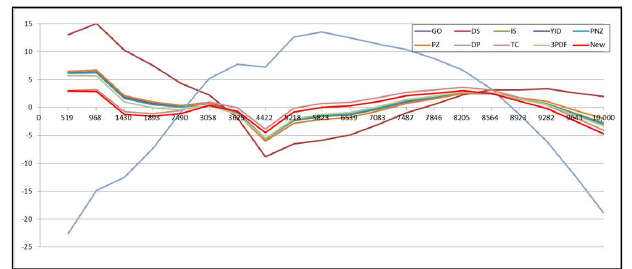
Figure 10. Relative error of the ten models for DS3.